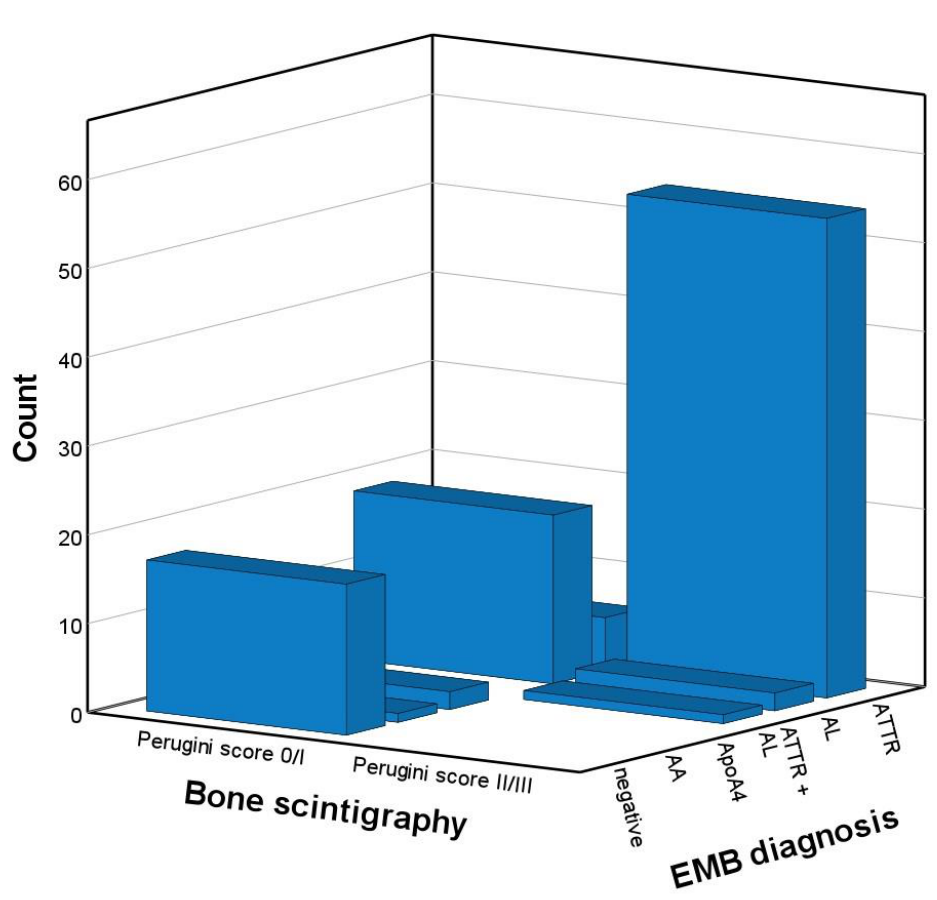
Figure 1. Endomyocardial biopsy-derived diagnoses stratified by Perugini score of 0/1 vs. 2/3 in the total sample (n = 102). AA, amyloid A; ApoA4, apolipoprotein A4; ATTR, transthyretin amyloidosis; AL, light chain amyloidosis; EMB, endomyocardial biopsy. Table 2. Diagnostic accuracy of bone scintigraphy with Perugini scorse ≥ 2 for the histopathological diagnosis of cardiac ATTR in the total sample (n = 102).